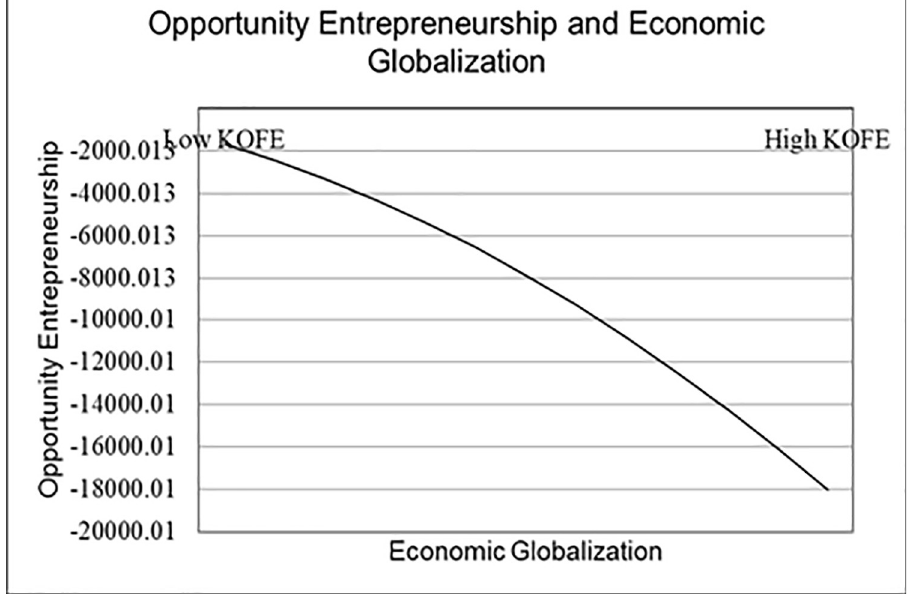
Fig 2. Quadratic fit of opportunity entrepreneurship and economic